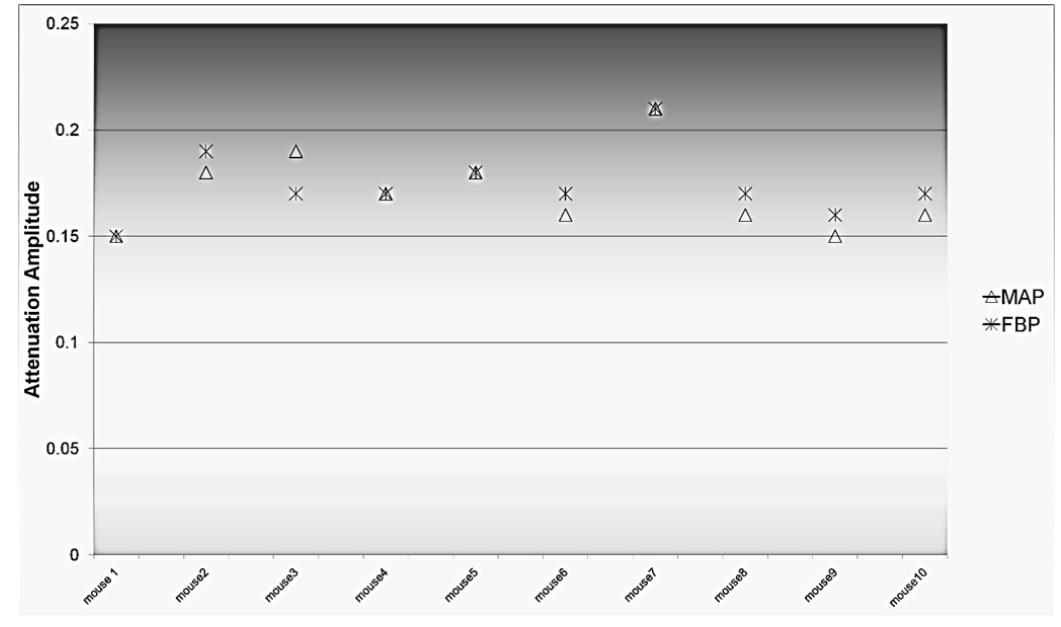
Figure 2. Comparison of the attenuation amplitude of the bladder for all mice using MAP and FBP reconstruction methods showed no significant variation.